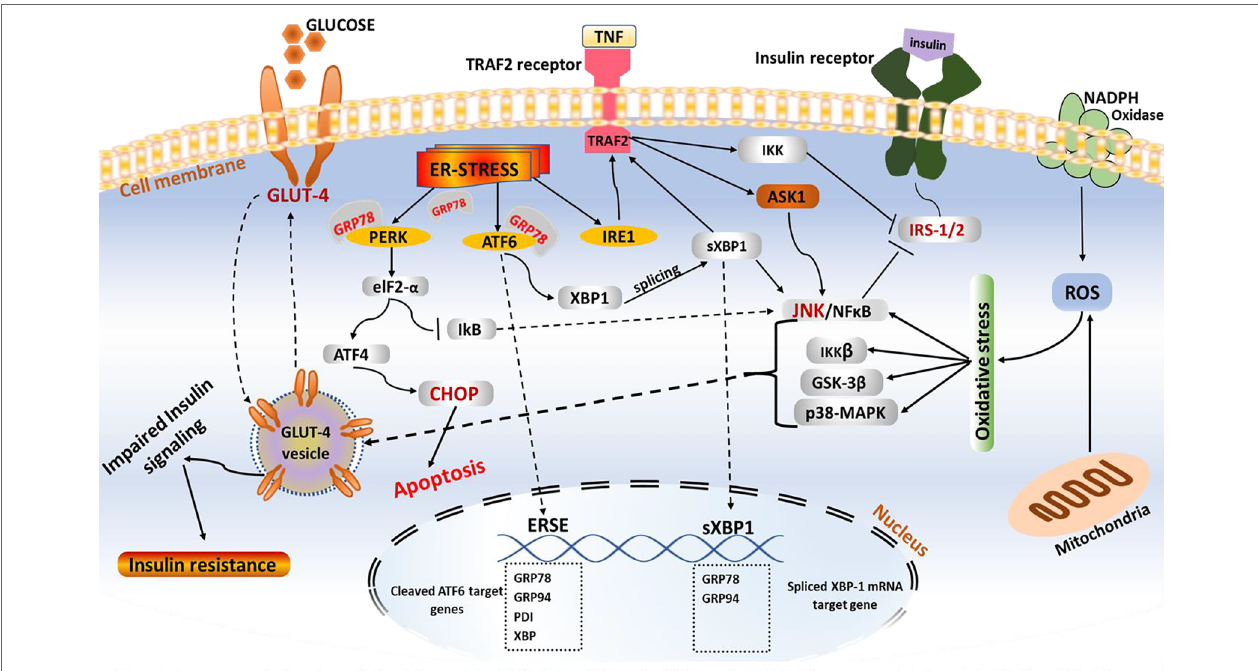
FIGURE 4 | ERS-mediated insulin resistance. Following the onset of ERS, the GRP78 BiP dissociates from the three central signaling receptors of the UPR (PERK, ATF6, and IRE-1). On the one hand, IRE1–JNK complex recruits TRAF2 leading to the formation of the IRE1–JNK–TRAF2 complex. The IRE1–JNK–TRAF2 complex has an effect on ASK1 activation, which may induce JNK phosphorylation, ultimately leading to ablation in insulin receptors and results in insulin resistance. Activated IRE-1 recruits TRAF2, and this complex causes activation of downstream signaling of kinases including JNK and NF- κ B, which induces production of inflammatory cytokines, which trigger inflammation. These inflammatory kinases then phosphorylate and activate downstream mediators of inflammation. Consequently, IRE-1-mediated JNK activation disrupts insulin receptor signaling and results in insulin resistance. Phosphorylation of one of these arms, namely, the IRE1 α , enhances recruitment of TRAF2, which further activates the c-JNK. In turn, c-JNK activation triggers increased production of proinflammatory markers, which are believed to alter insulin receptor and leads to insulin resistance. On the other hand, phosphorylation of IRE-1 α fosters phosphorylation of IRS-1 through JNK-dependent serine and thus inhibits insulin receptor